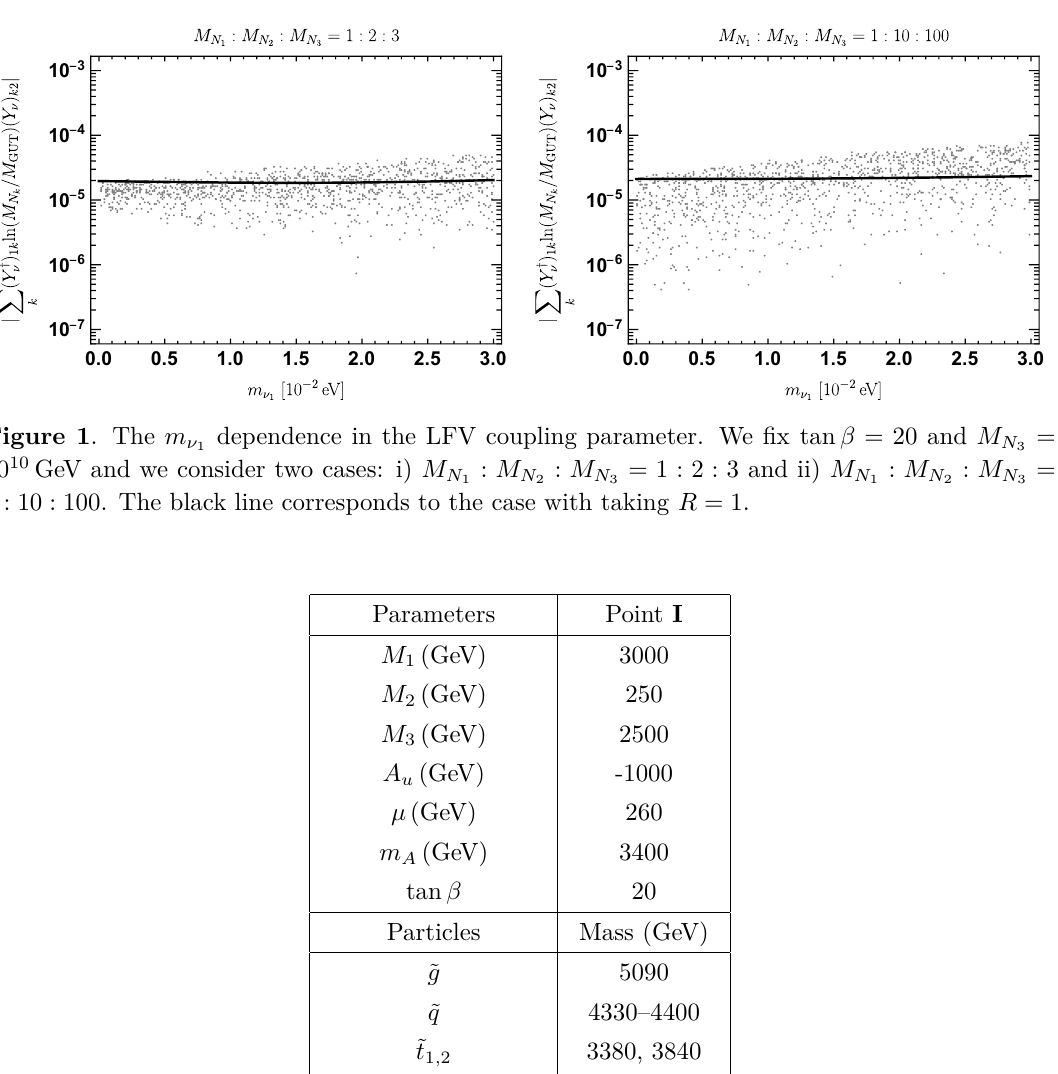
dependence in the LFV coupling parameter. We fix tan β = 20 and M N 1